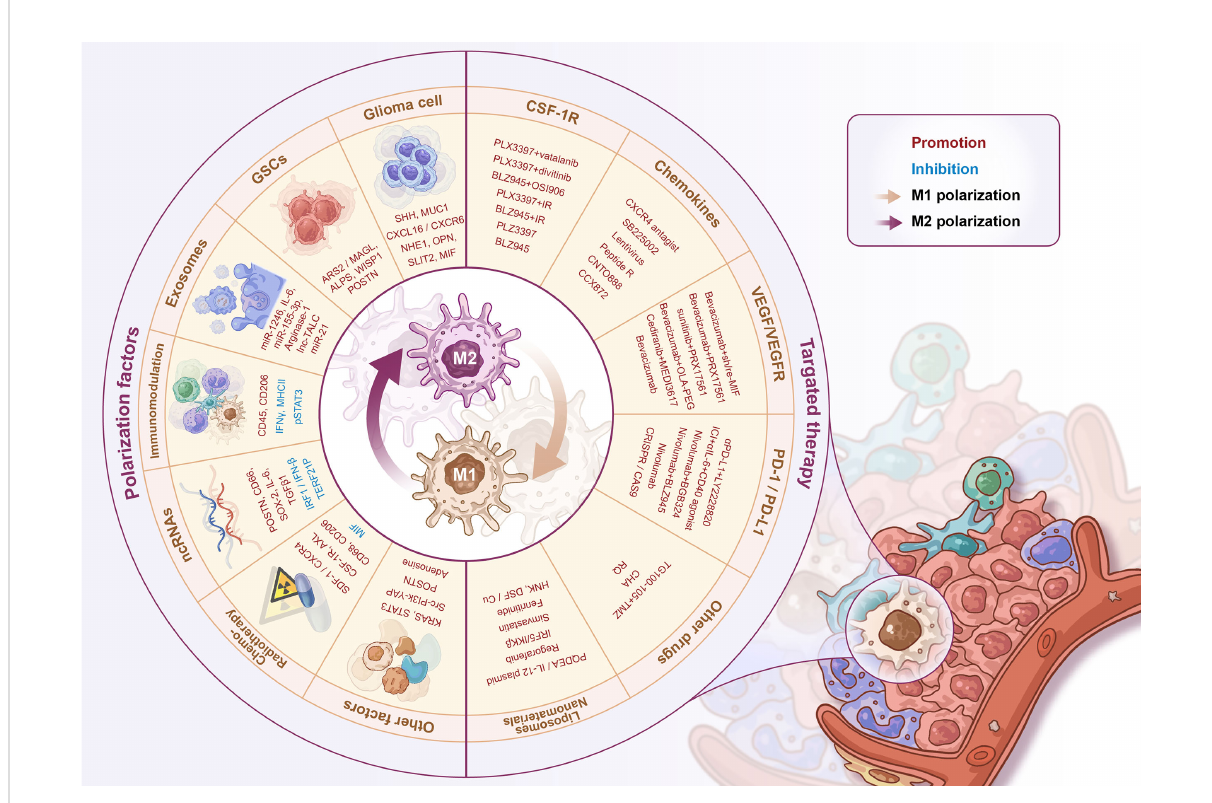
FIGURE 2 Regulators of M1-M2 polarization and GAMs ’ targeted therapy. The regulators of GAMs polarization include a variety of soluble factors secreted by glioma cells/stem cells, exosomes, immune-related molecules, non-coding RNAs, radio-chemotherapy and some other proteins, signaling pathways, etc. The GAMs targeted therapy strategies include CSF-1R inhibitors, chemokine inhibitors, anti-angiogenic therapy, PD-1/PD-L1 inhibitors, and novel liposome/nanomaterial delivery systems for drug